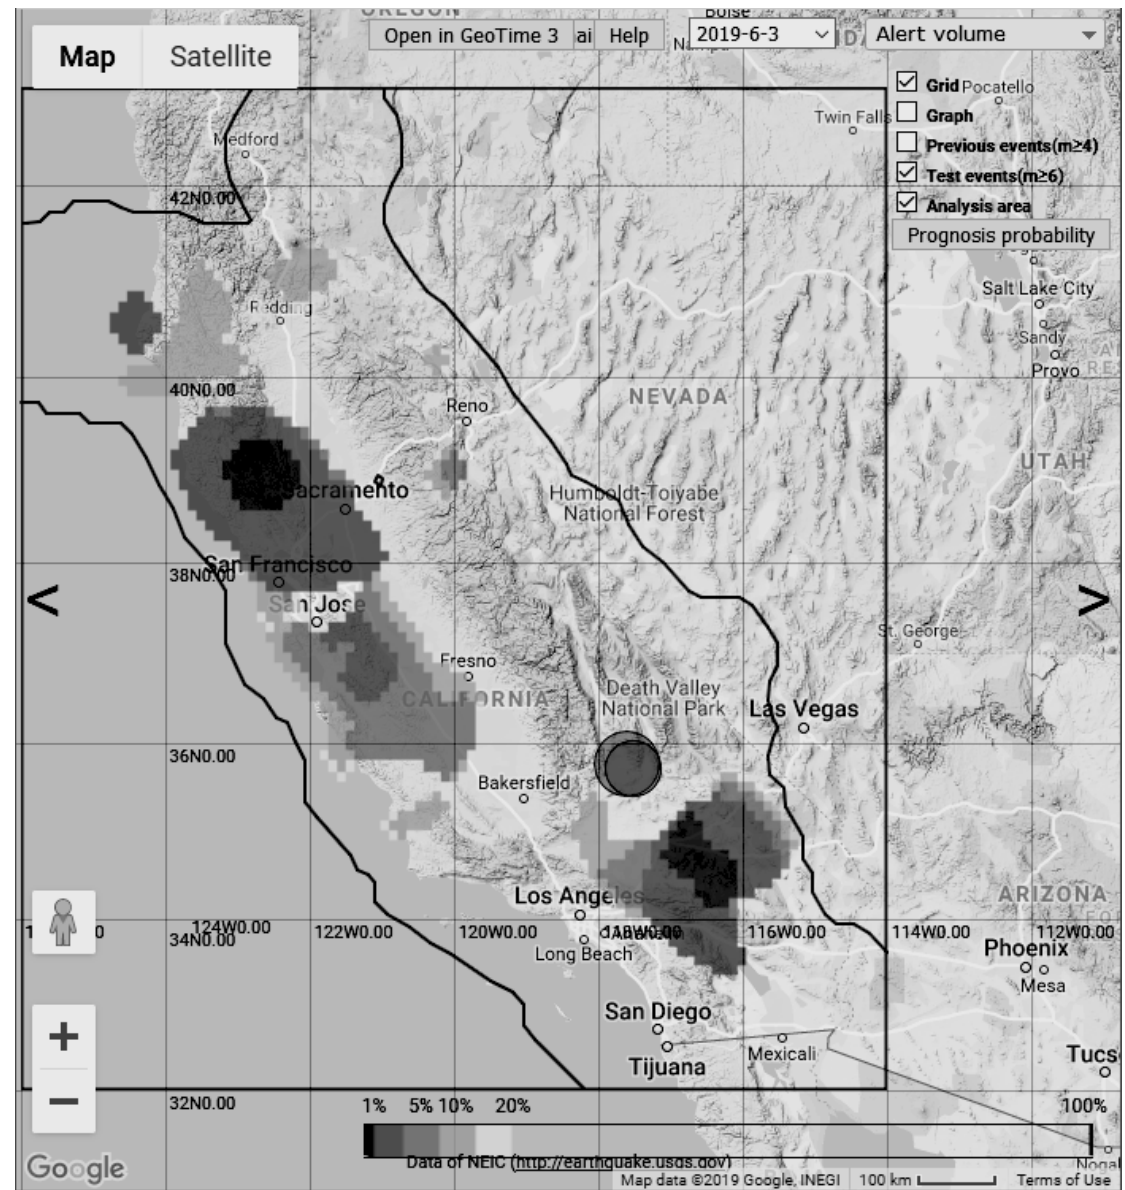
Figure 6. Screenshot of the web-based platform working window: The map shows the alarm zone for earthquakes with a magnitude M ≥ 5.7 and the epicenters of earthquakes of 4 July 2019 with a magnitude of 6.4 and 6 July 2019 with a magnitude of 7.1 calculated during training according to data until 3 June 2019. The palette shows areas with different alarm volumes in percent: 1%, 5%, 10%, 15%,